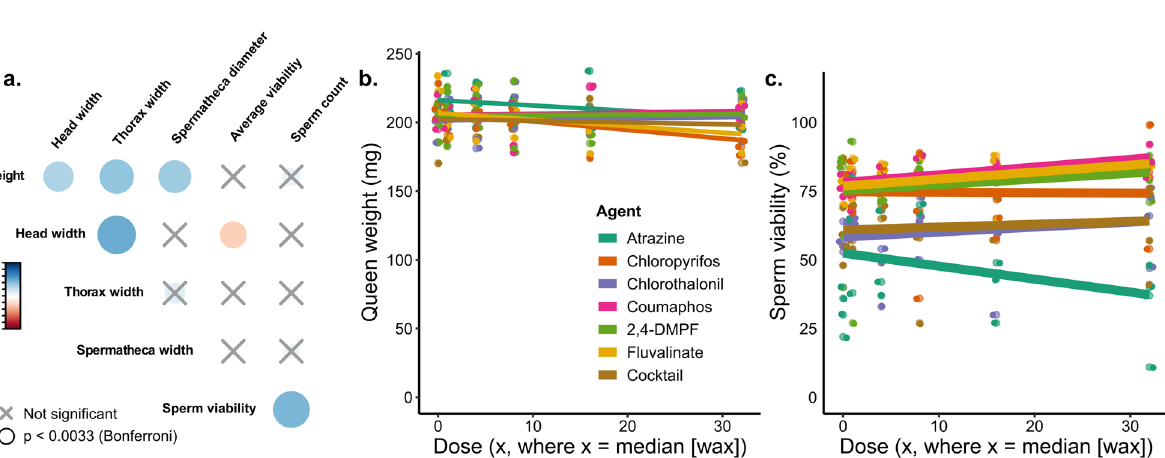
Figure 1. Evaluating the effect of pesticide doses on queen quality metrics . N = 4 queens were exposed topically (2 µl to the thorax, acetone solvent) to each pesticide and each dose, for a total of 168 queens. a) Queen quality metrics were recorded after exposure. The colour bar is proportional to the Pearson correlation coefficients. Neither queen weight (b) nor sperm viability (c) depends on dose or pesticide. See Table 2 for a complete statistical summary.